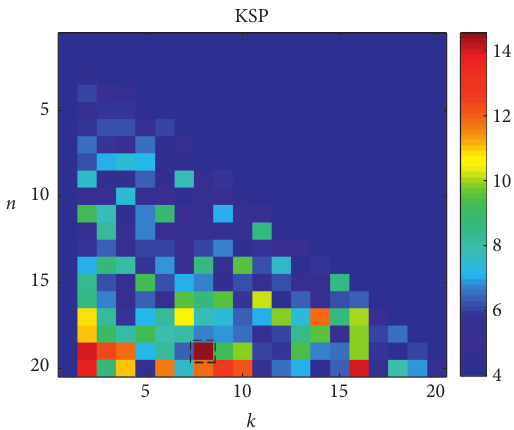
Figure 6: KSP obtained after noise reduction by